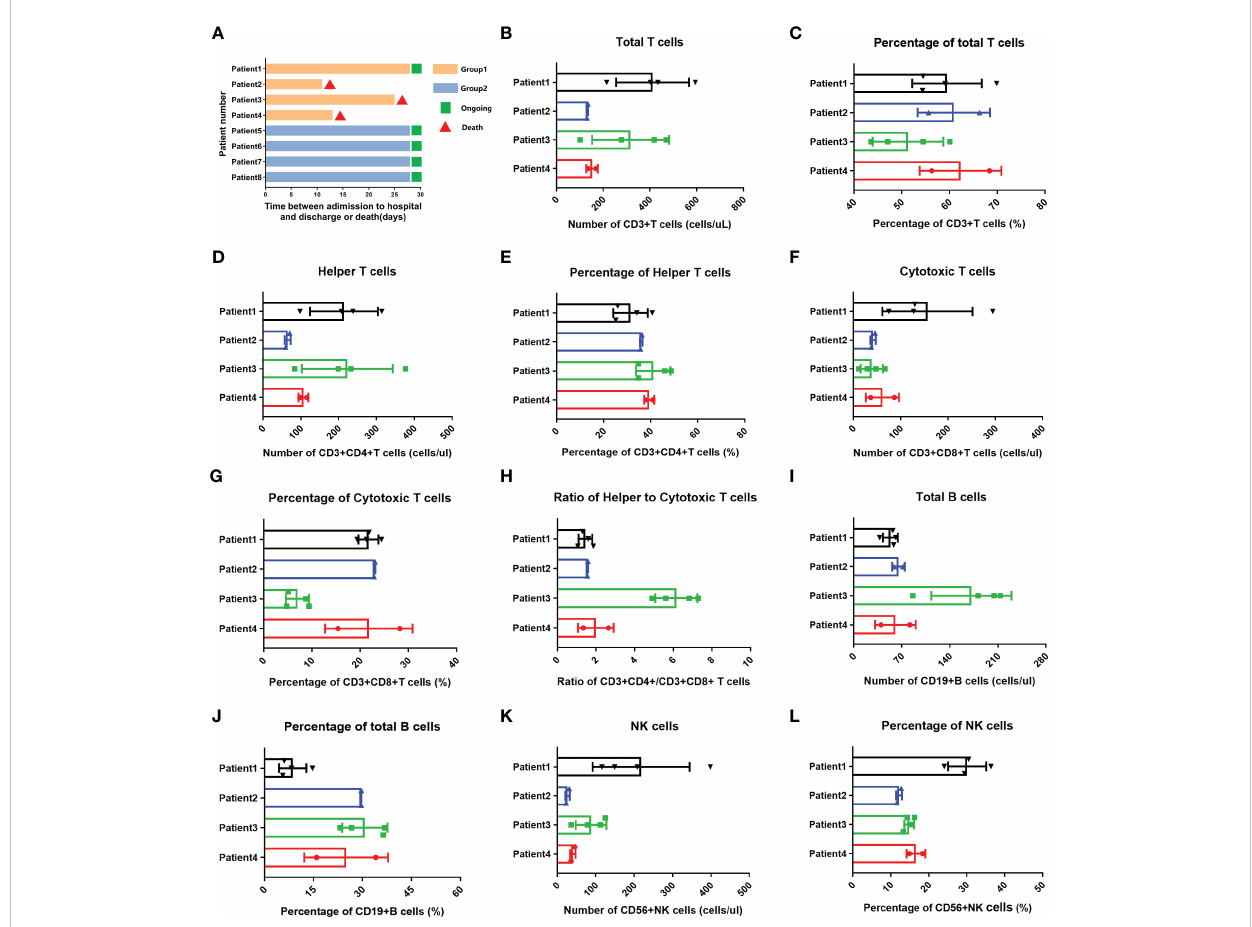
FIGURE 3 Swimmer plots for patient survival and comparisons of lymphocyte subsets in four cancer patients with omicron infection. (A) Of cancer patients with omicron infection, Patient 1 survived, but Patients 2, 3, and 4 died after Omicron virus infection on the 11th, 25th (9 days after the virus test was negative), and 13th. Of the cancer patients without Omicron infection, Patients 5, 6, 7, and 8 all survived. The comparisons of count of total T cells in four cancer patients with Omicron virus infection during clinical observation (B) , percentage of total T cells (C) , count of helper T lymphocytes (D) , percentage of helper T lymphocytes (E) , count of cytotoxic T cells (F) , percentage of cytotoxic T cells (G) , ratio of helper to cytotoxic T lymphocytes (H) , count of total B cells (I) , percentage of total B cells (J) , count of NK cells (K) , percentage of NK cells (L)